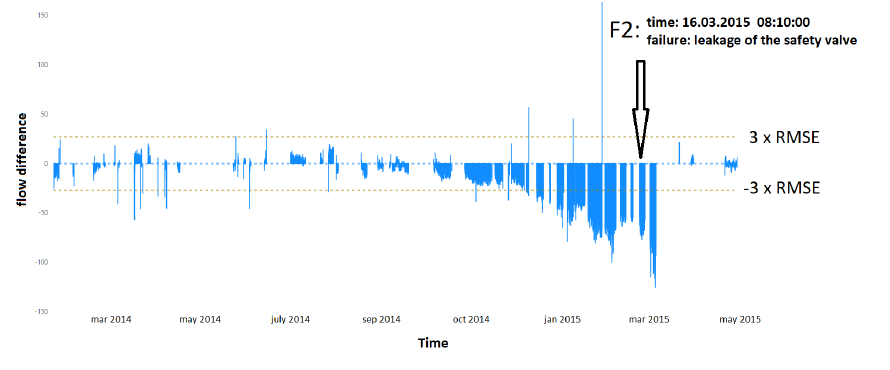
Figure 7. Difference between the real and estimated value of the water flow. F, Failure.